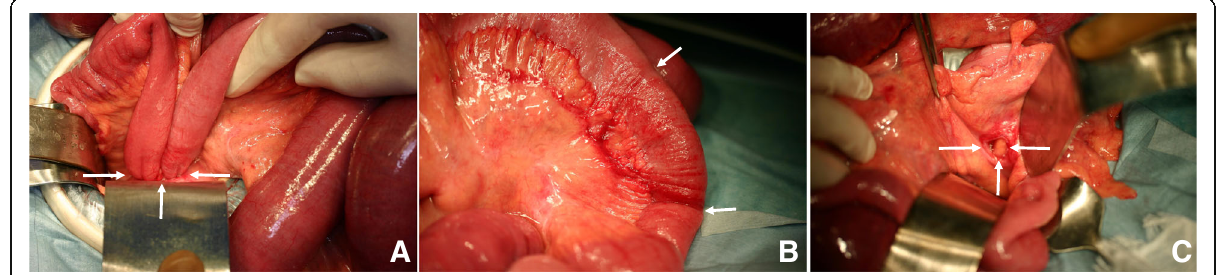
Fig. 2 a Findings at laparotomy. The incarcerated small bowel was located approximately 75 cm proximal to the ileocecal junction, into the mesosigmoid through the right lobe (arrows). b The released ileum, measuring 6 cm in length, appeared viable and without severe color change (between the two arrows). c The incarcerated ileum was gently released. The orifice located at the central part of the right lobe of the mesosigmoid was oval shaped and measured less than 2 cm in diameter (arrows). The intact inside of the left lobe was seen through the